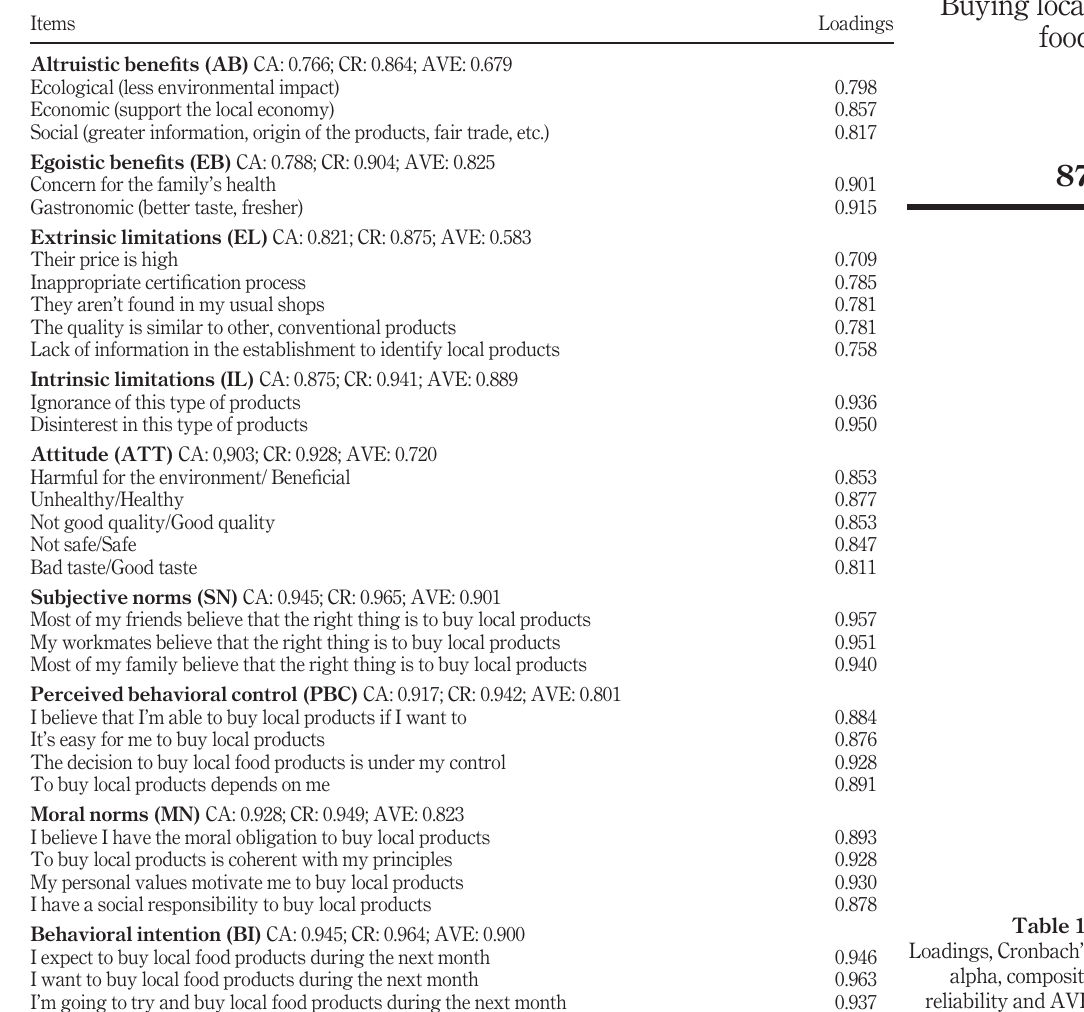
Table 1. Loadings, Cronbach ’